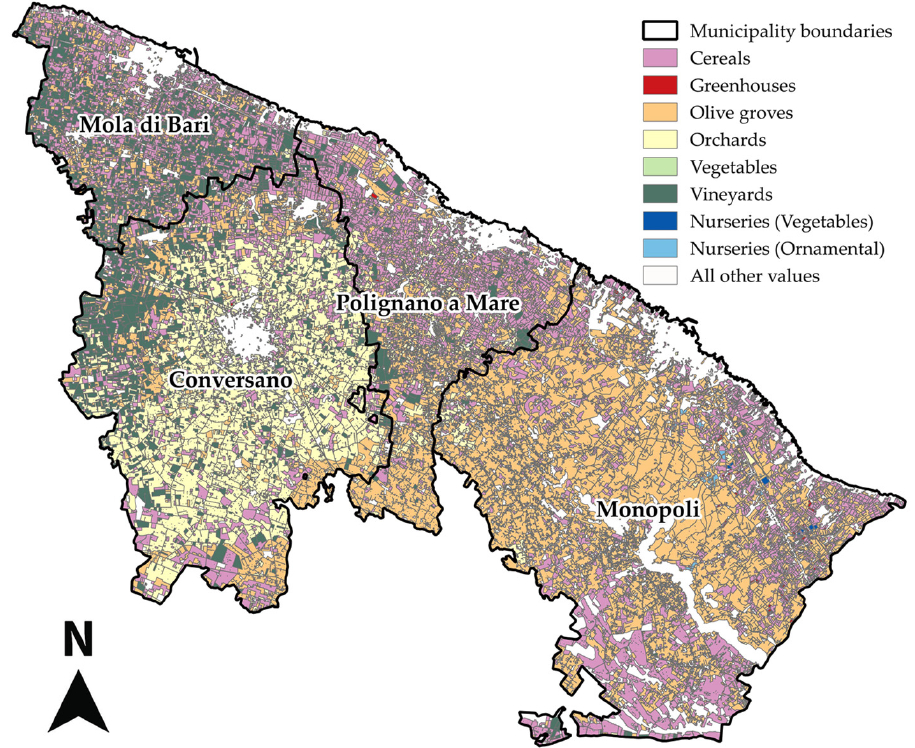
Figure 1. Land-use map of the study area taken by elaborations made using the QGIS software.